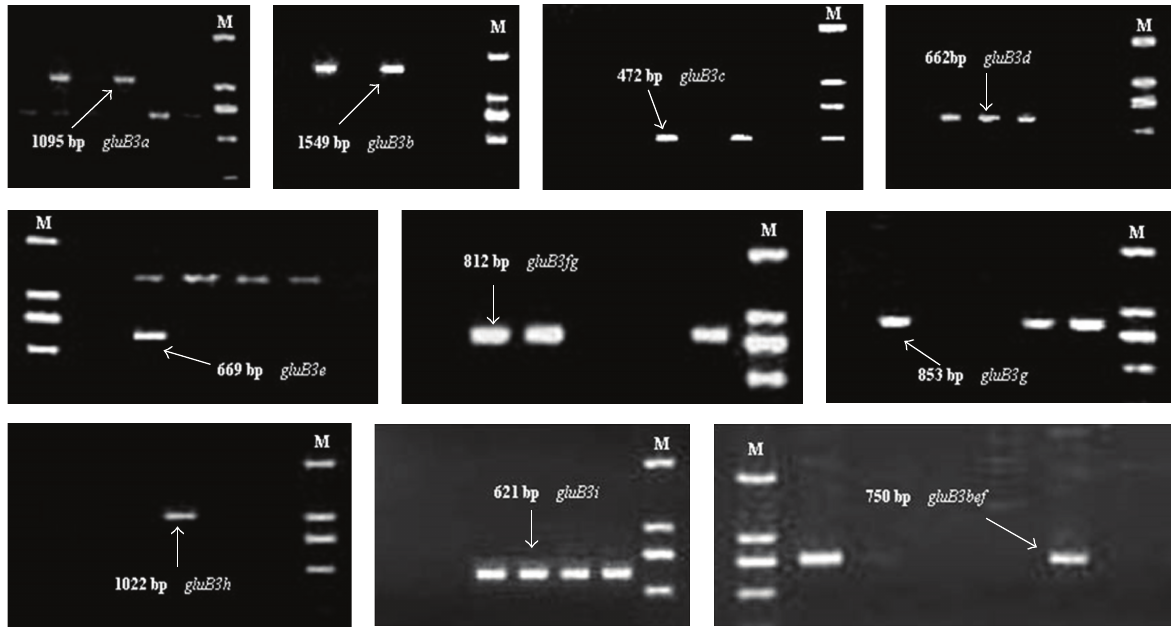
Figure 1: PCR products amplified from some varieties using 10 Glu-B3 allele-specific markers.